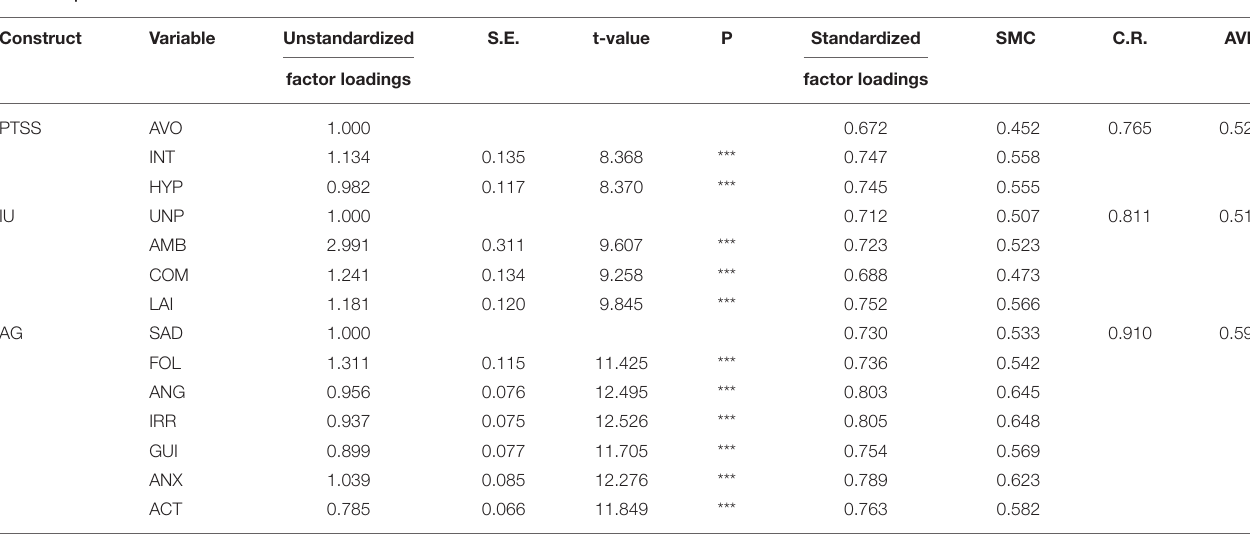
TABLE 2 | CFA for the measurement model.